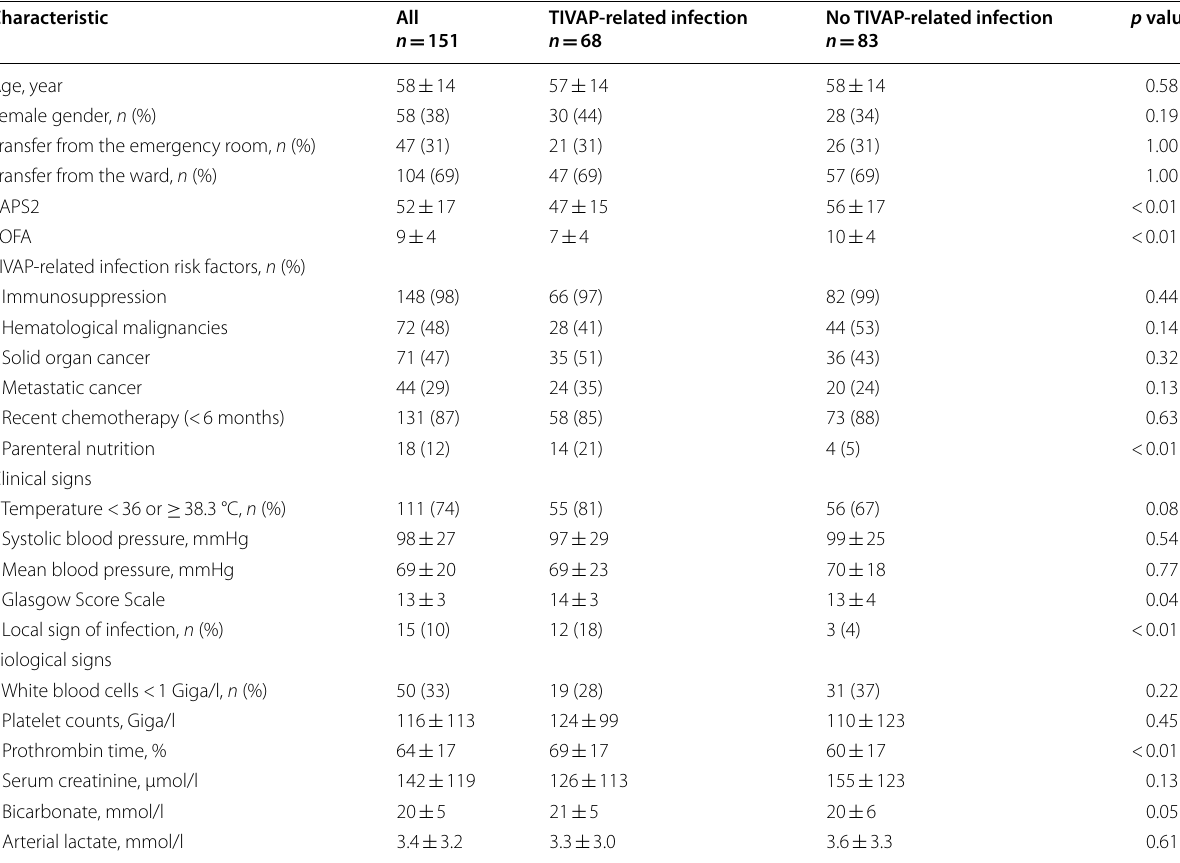
Categorical variables are expressed as no. (%) and continuous variables as mean SAPS2 Simplified Acute Physiology Score, SOFA Sepsis-Related Organ Failure Assessment, TIVAP totally implanted venous access